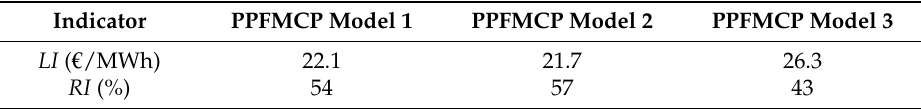
Table 7. Values of indicators LI and RI .